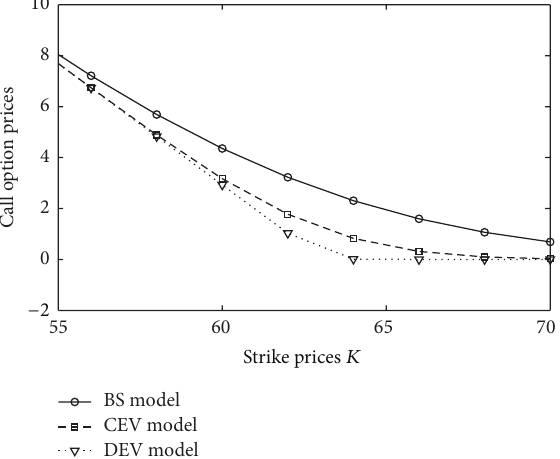
Figure 12: Call option prices at 𝑆 0 = 65 during subprime